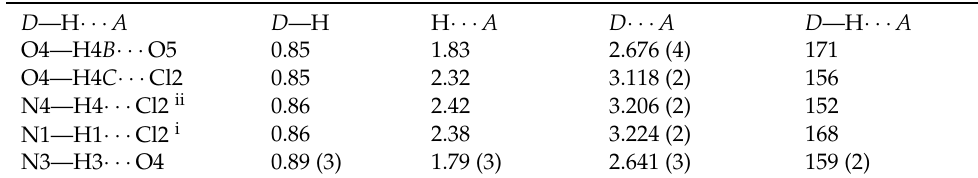
Table 5. Hydrogen-bond geometry (Å, º) for (III).